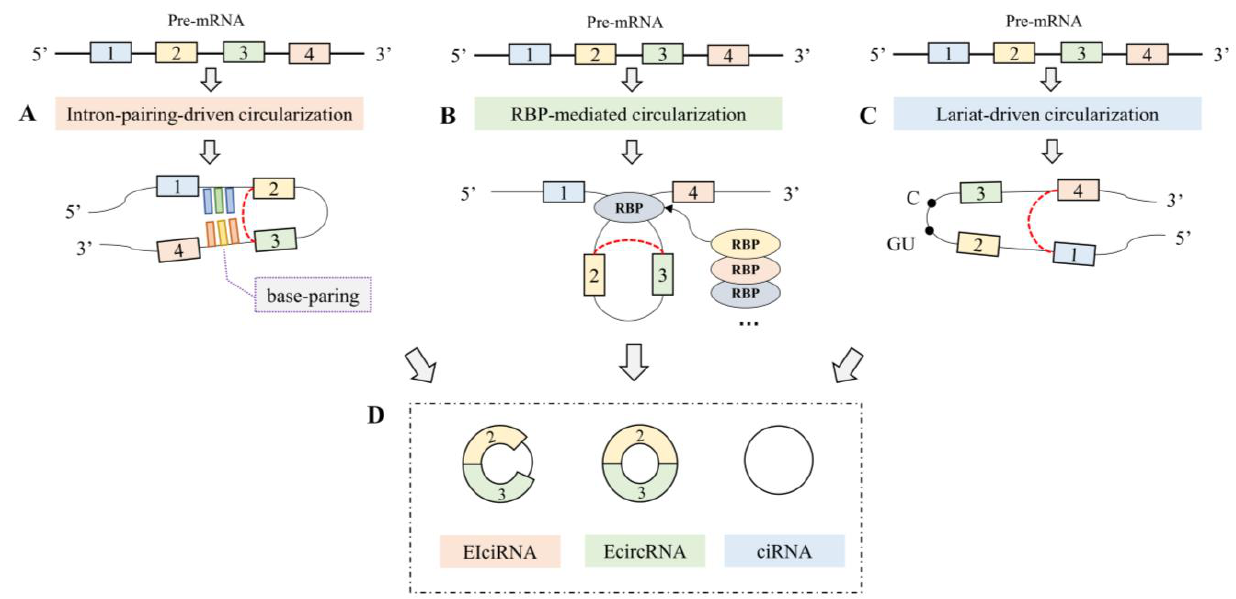
Figure 1. Biogenesis and structures of circRNAs: ( A ) intron-pairing-driven circularization; ( B ) RBP- mediated circularization; ( C ) lariat-driven circularization; ( D ) sdifferent circRNA structures. (EI- ciRNA: exon–intron circRNA; EcircRNA: exonic circRNA; ciRNA: intronic